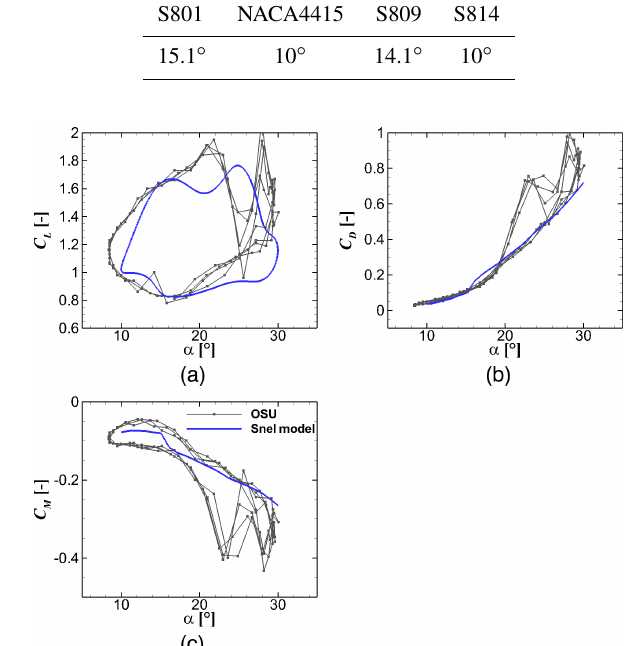
Figure 7. Dynamic force reconstruction using the Snel model in comparison with the measurement data (Ramsay et al., 1996) for (cid:49)t = T/ 1440. S801 airfoil, k = 0 . 073, α = 20 ◦ and (cid:49)α = 10 ◦ .